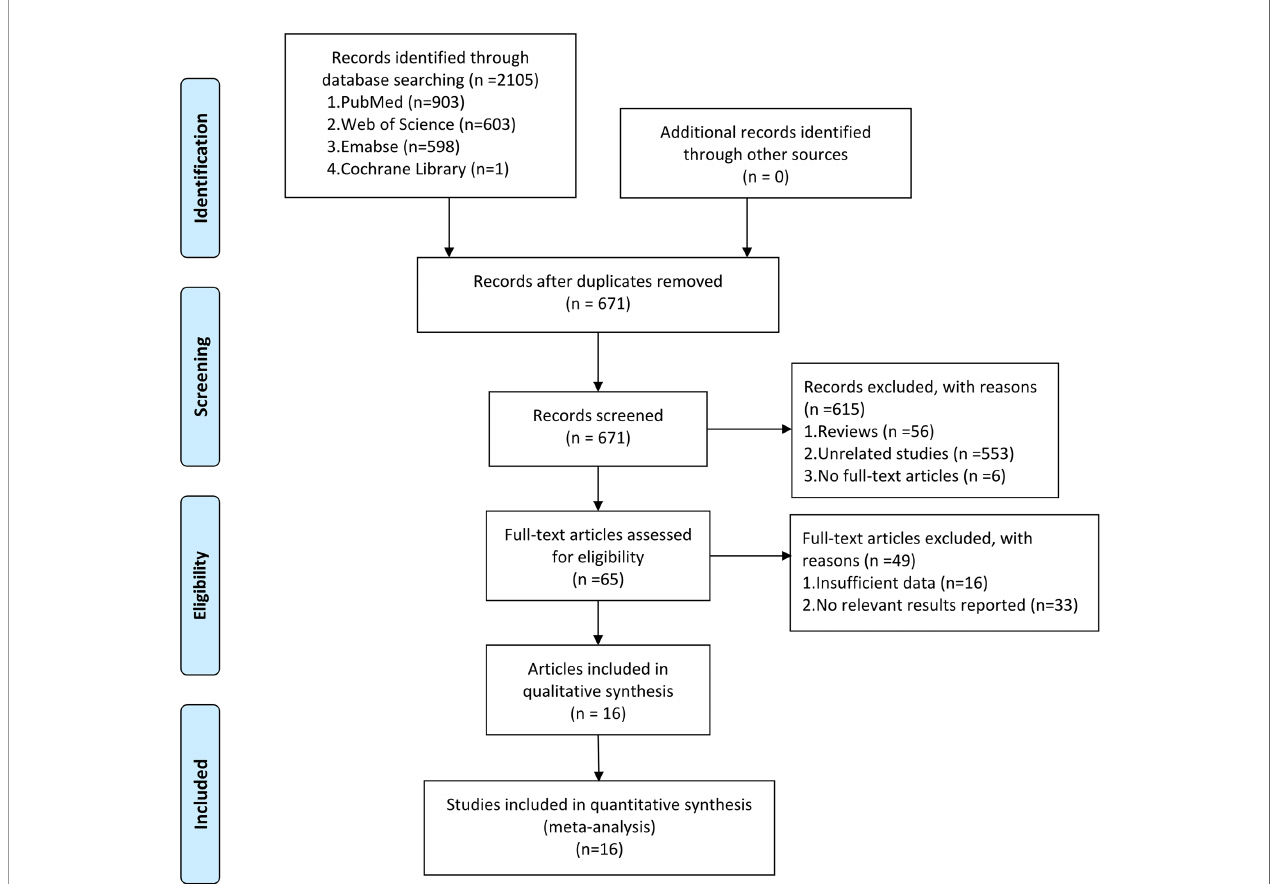
FIGURE 1 | The PRISMA fl ow diagram showing the process of eligible studies search and selection. This meta-analysis identi fi ed 16 eligible studies that used circRNAs as biomarkers for tumor